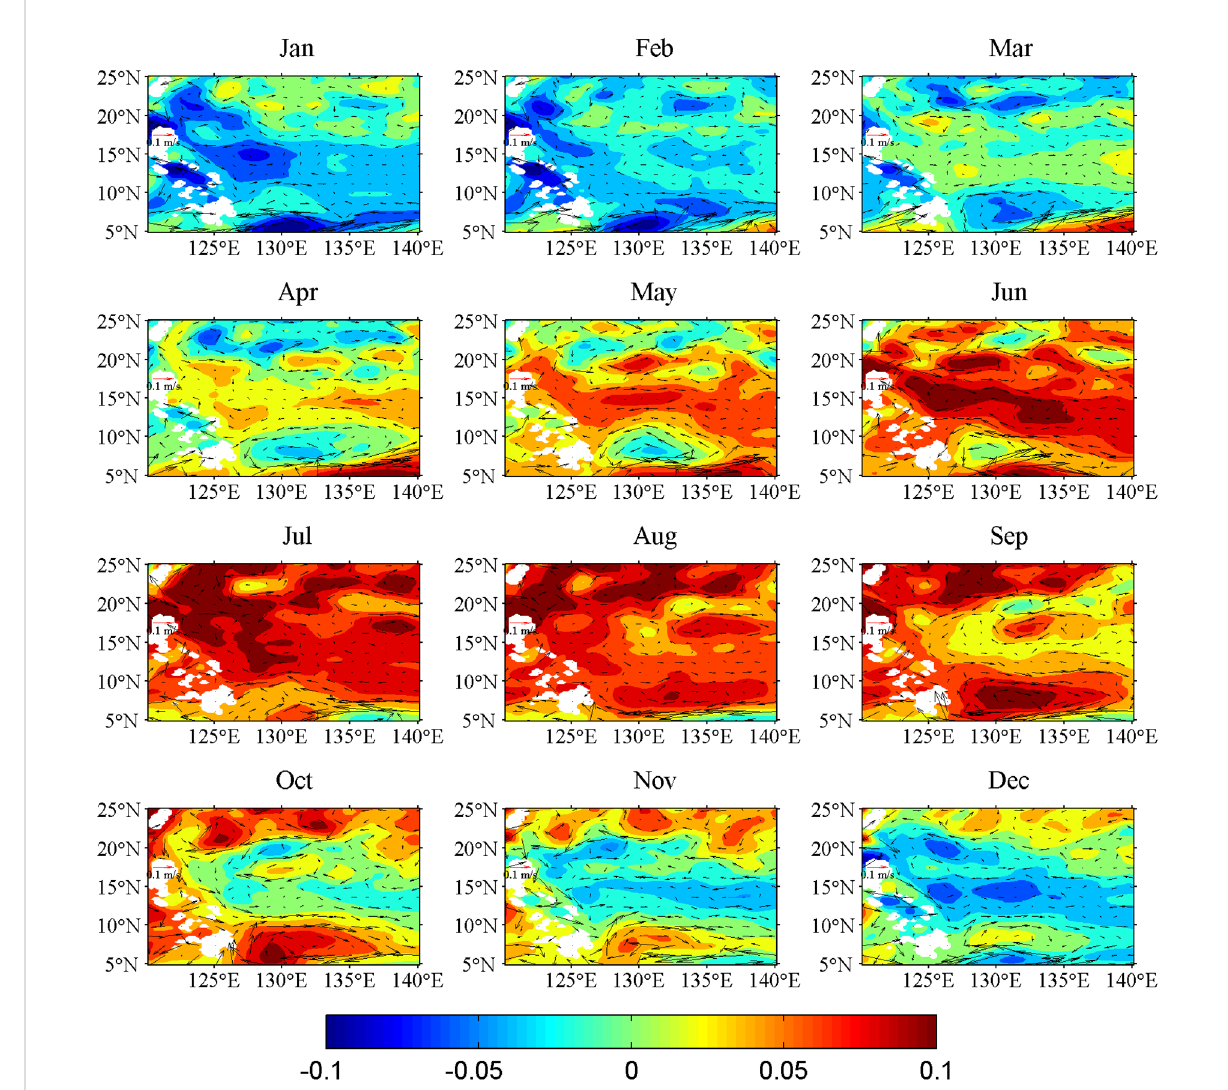
FIGURE 7 Spatial distribution of seasonal SSHa and associated geostrophic current anomalies (represented by arrows) based on satellite data (1993 – 2019) east of the Philippines. (Units are